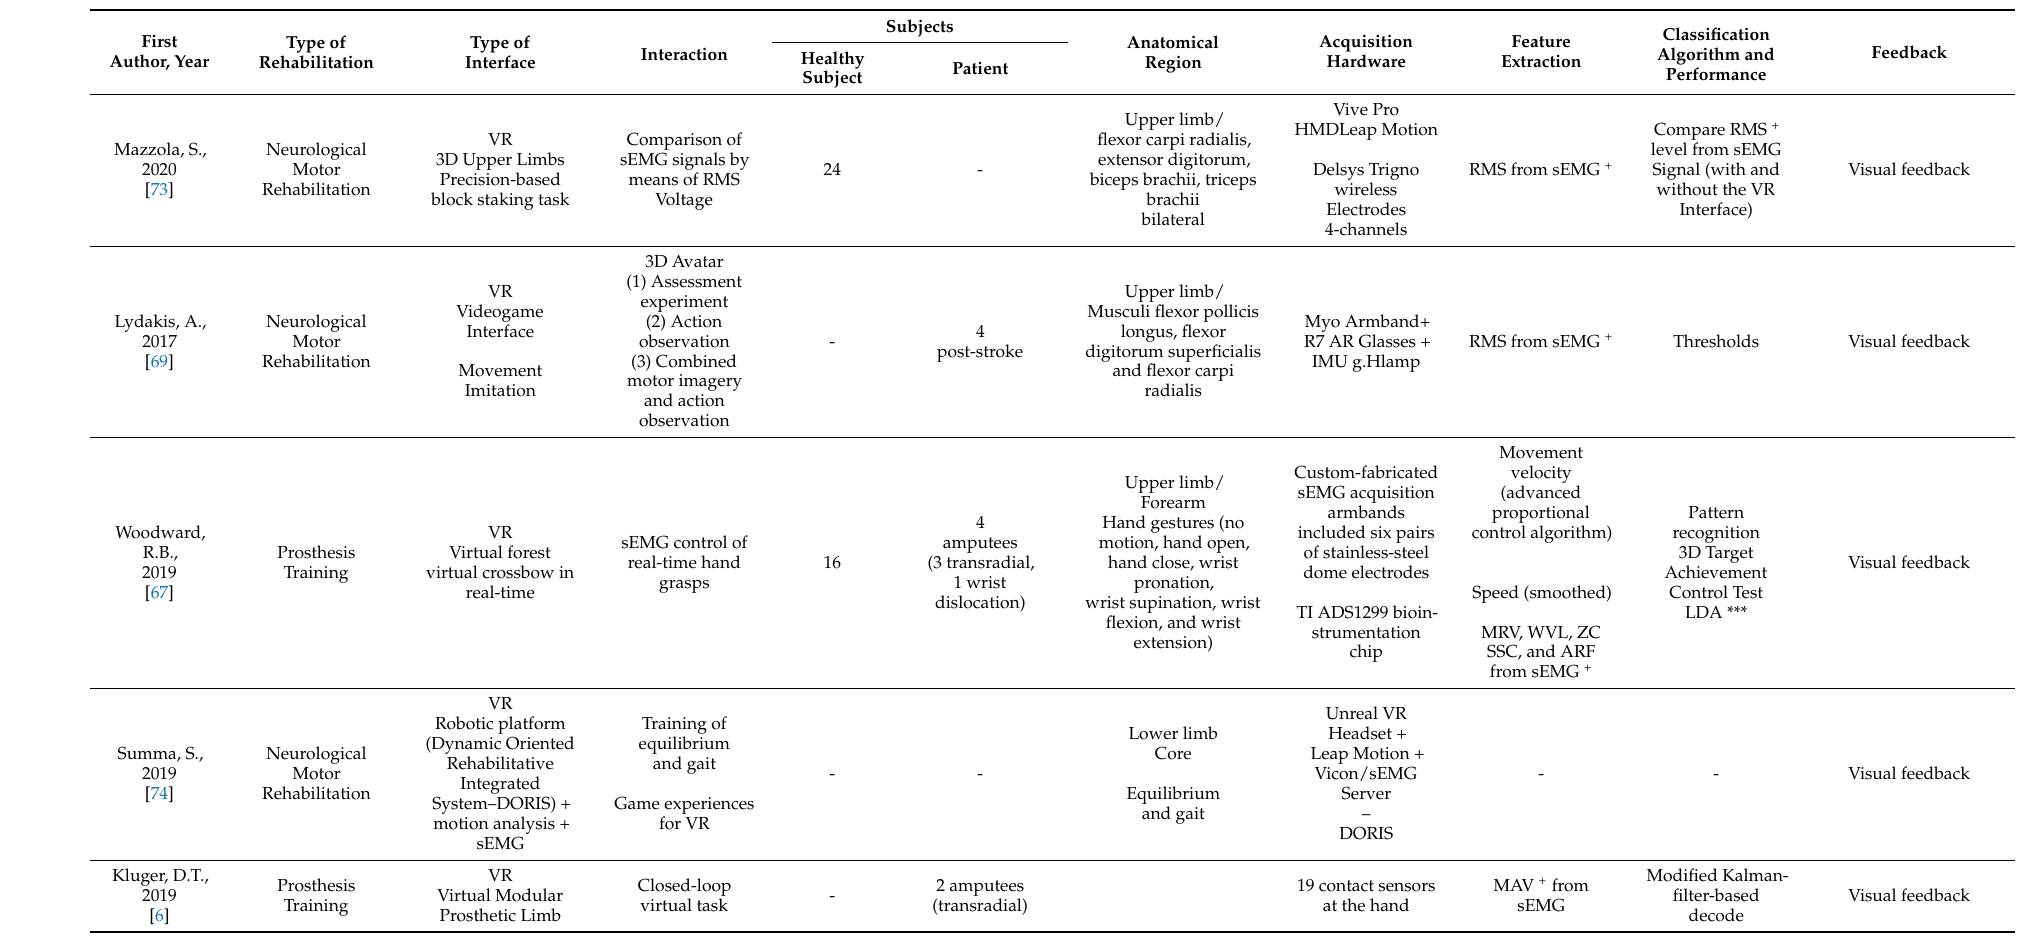
Table 1. VR interfaces used for motor rehabilitation based on sEMG